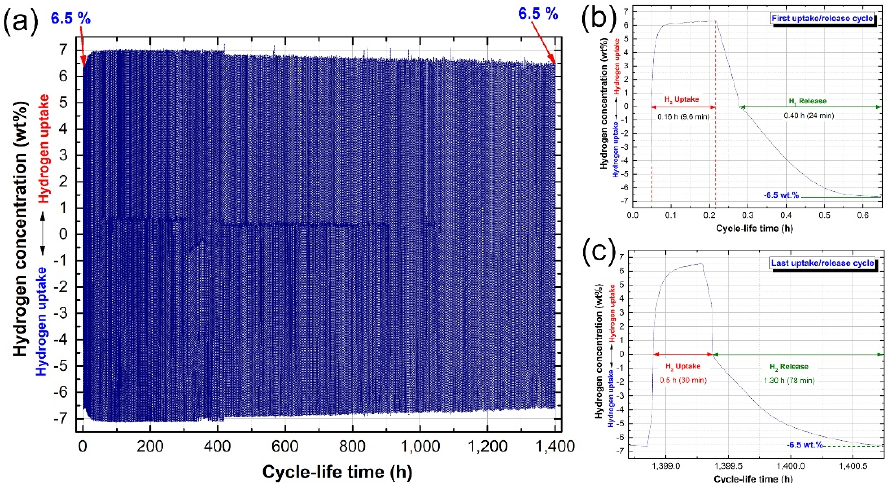
Figure 14. ( a ) Hydrogenation/dehydrogenation cycle lifetime of MgH 2 /5 wt% ZrC binary system, examined for 1400 h at 225 ◦ C under uptake and hydrogen pressures of 10 and 0.4 bar, respectively. The hydrogenation/dehydrogenation cycles after the first and last cycles are presented in ( b ) and ( c ), respectively. However, a marginal decrease (~less than 0.5 wt.% H 2 ) in the storage capacity